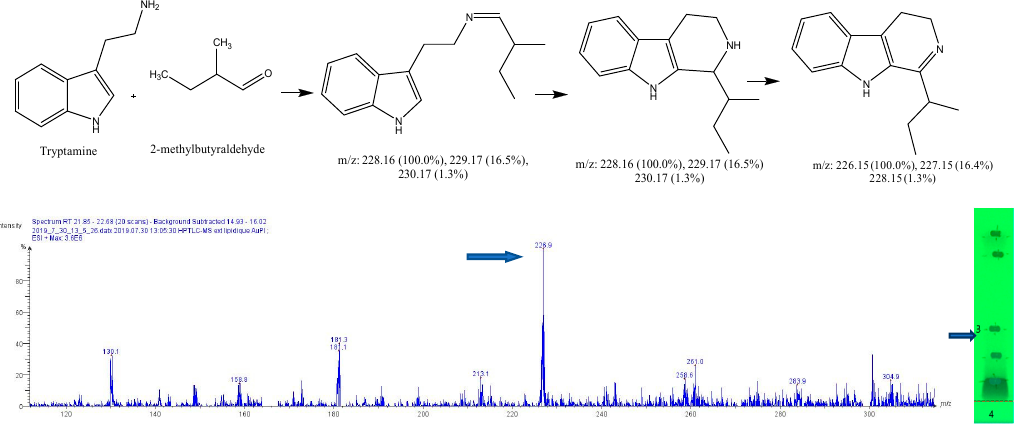
Figure 11. Expected reaction between serotonin and hexanal. Mass spectrum for the spot of the reaction mixture on MS grade TLC plate.